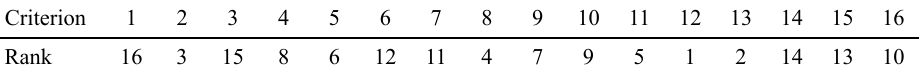
Table 4. The ranks of system’s criteria assigned by experts